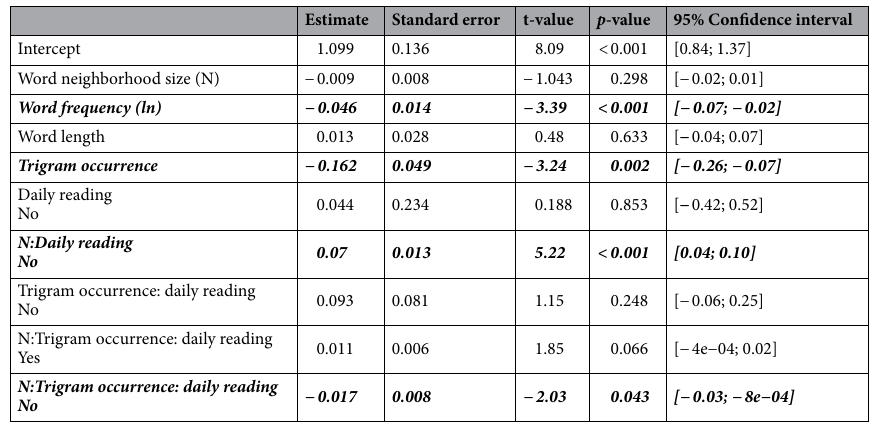
Table 5. Fixed-effects estimates from the complex LME model (analysis 3). The dependent variable is log- transformed target word total reading time. The intercept estimate represents the log-transformed reading time when all factors included in the model are at their reference level (categorical variable) or at 0 (continuous variable). Reference level for the binary factor “Daily reading” is ‘yes’. Interactions are represented by the symbol “:”. Factors showing a significant effect on reading time are in bold font and highlighted in italic.